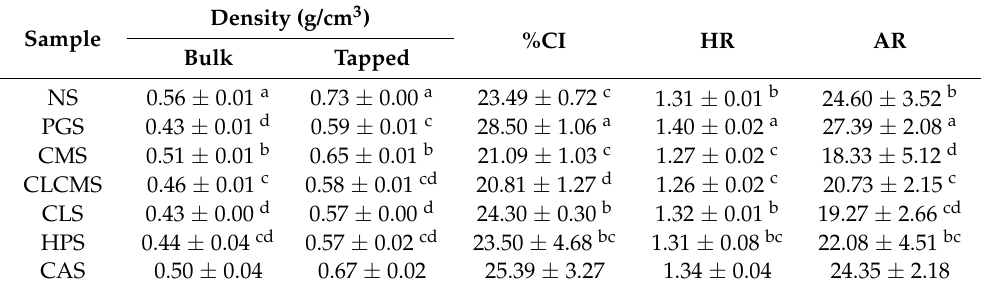
Table 4. Density and Flow Properties of Native and Modified CMU-107 Starches